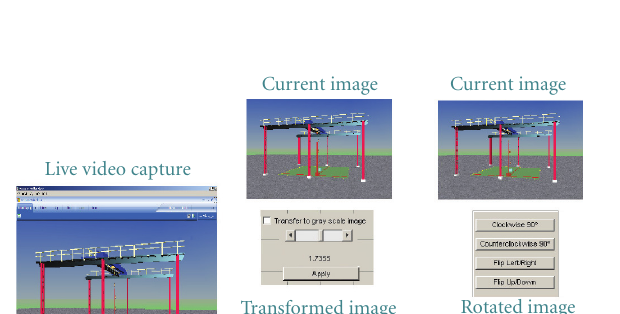
Figure 3: Data acquisition adapter.